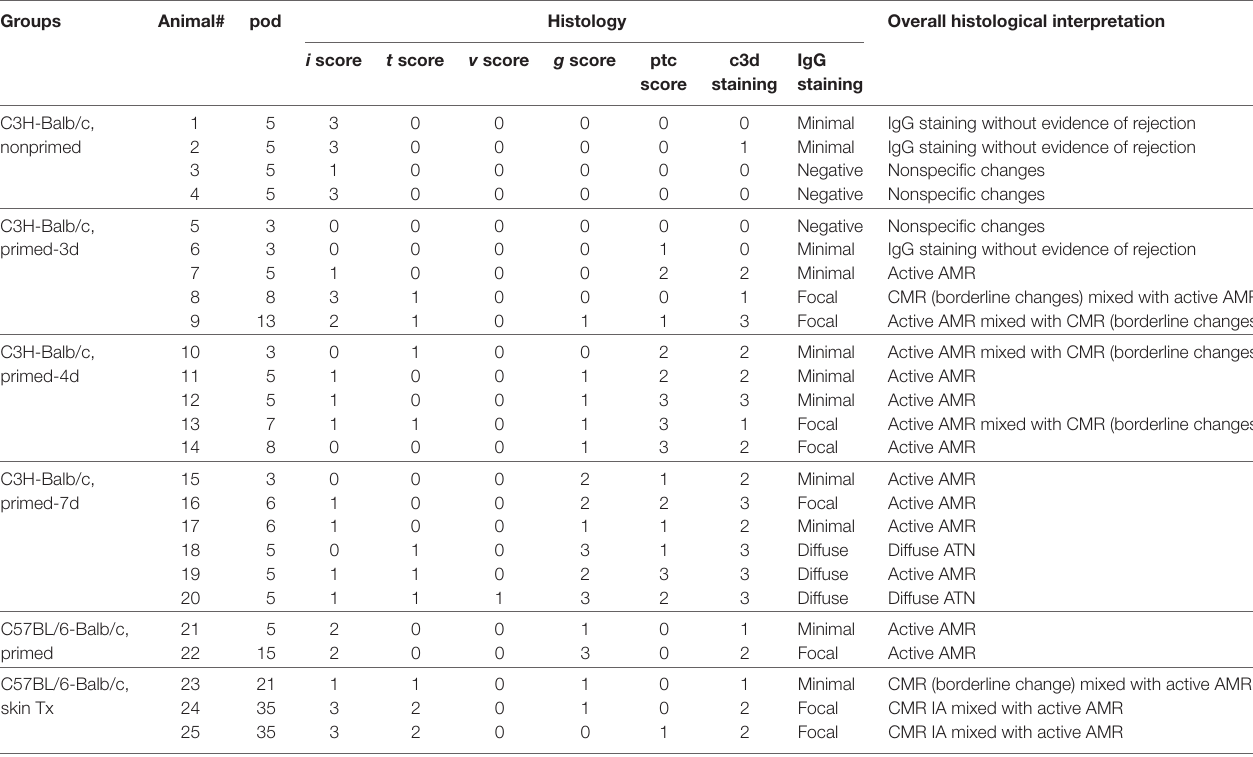
Table 3 | Summary of morphological findings in renal allografts. groups animal# pod